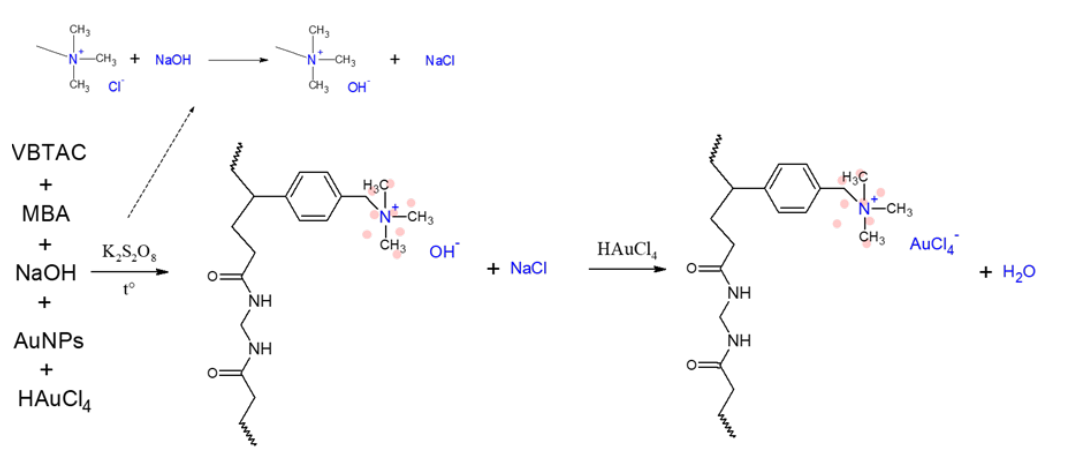
Figure 8. Reactions occurring during synthesis of the sample NC3 (addition of